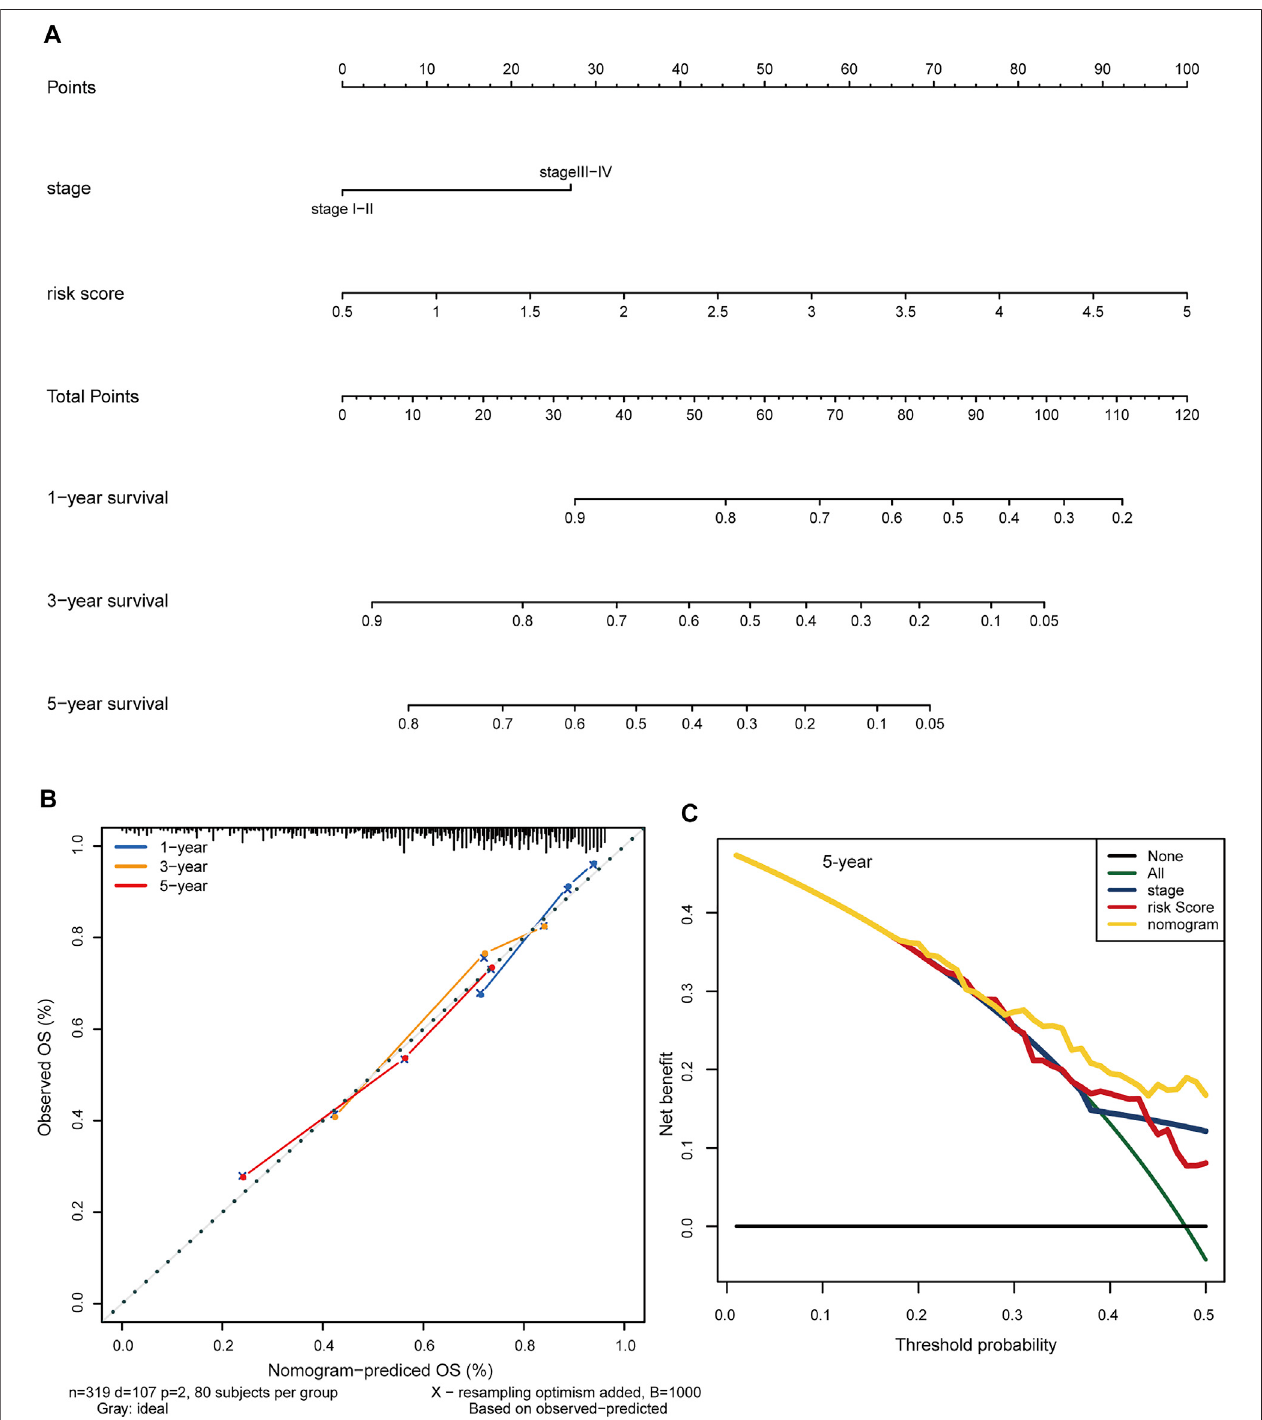
FIGURE 8| Construction of aclinical predictive nomogram to improve the prognostic prediction in HCC. (A) The hybrid nomogram combiningthe hypoxia-related risk score withthe AJCC stage. Patients were given atotal risk score based on each factor level in the nomogram. (B) Calibration curves show the consistencybetween thenomogram-predictedOSprobabilityandtheobservedOSprobability. (C) DCAcurvesillustratethe5-yearsclinicalnetbene fi tofthecombinednomogramcompared with other individual models. HCC: hepatocellular carcinoma. OS: overall survival. DCA: decision curve analysis.